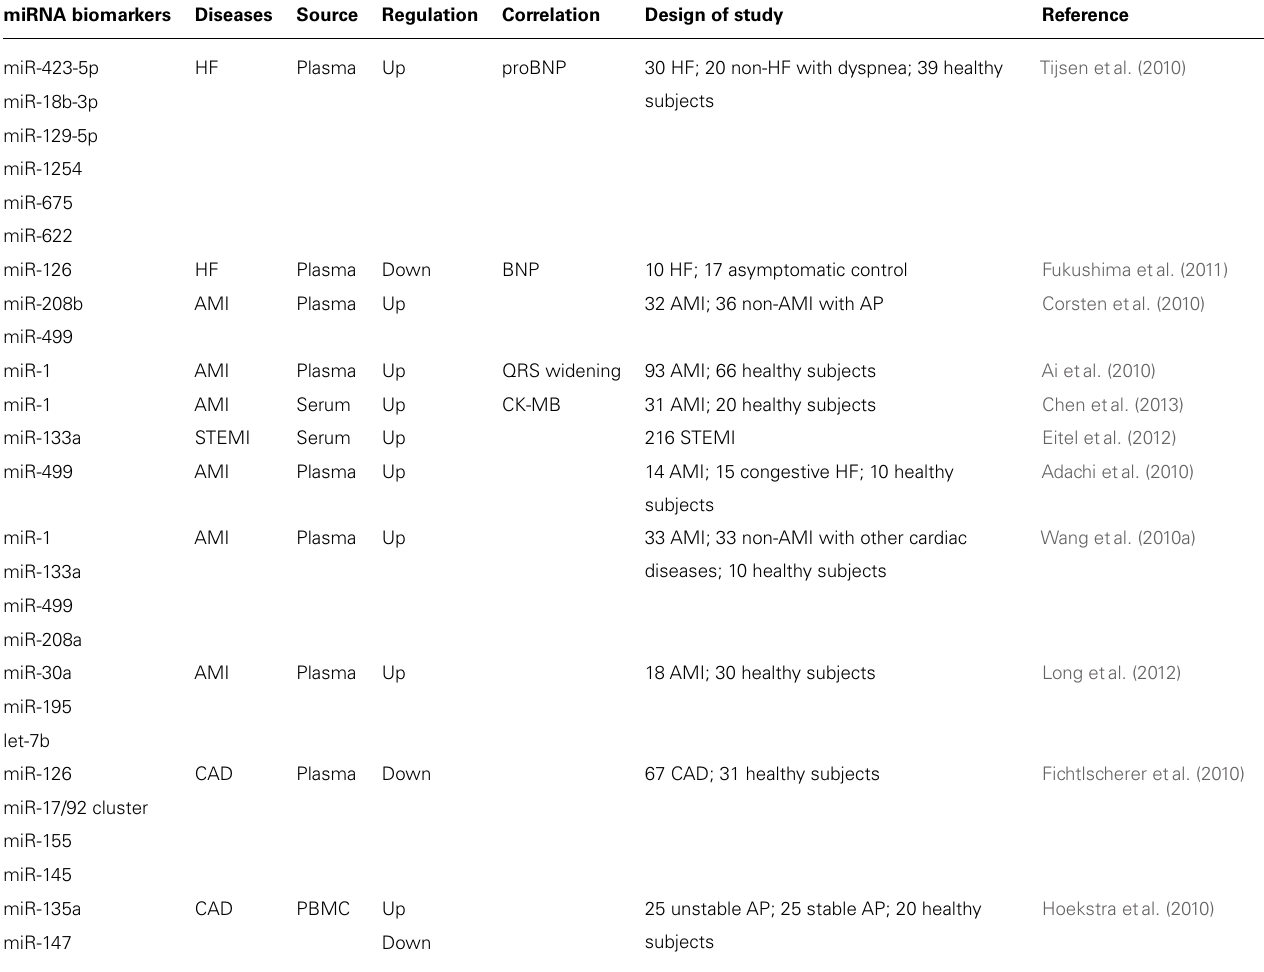
Table 1 | Extracellular miRNAs as biomarkers in cardiovascular